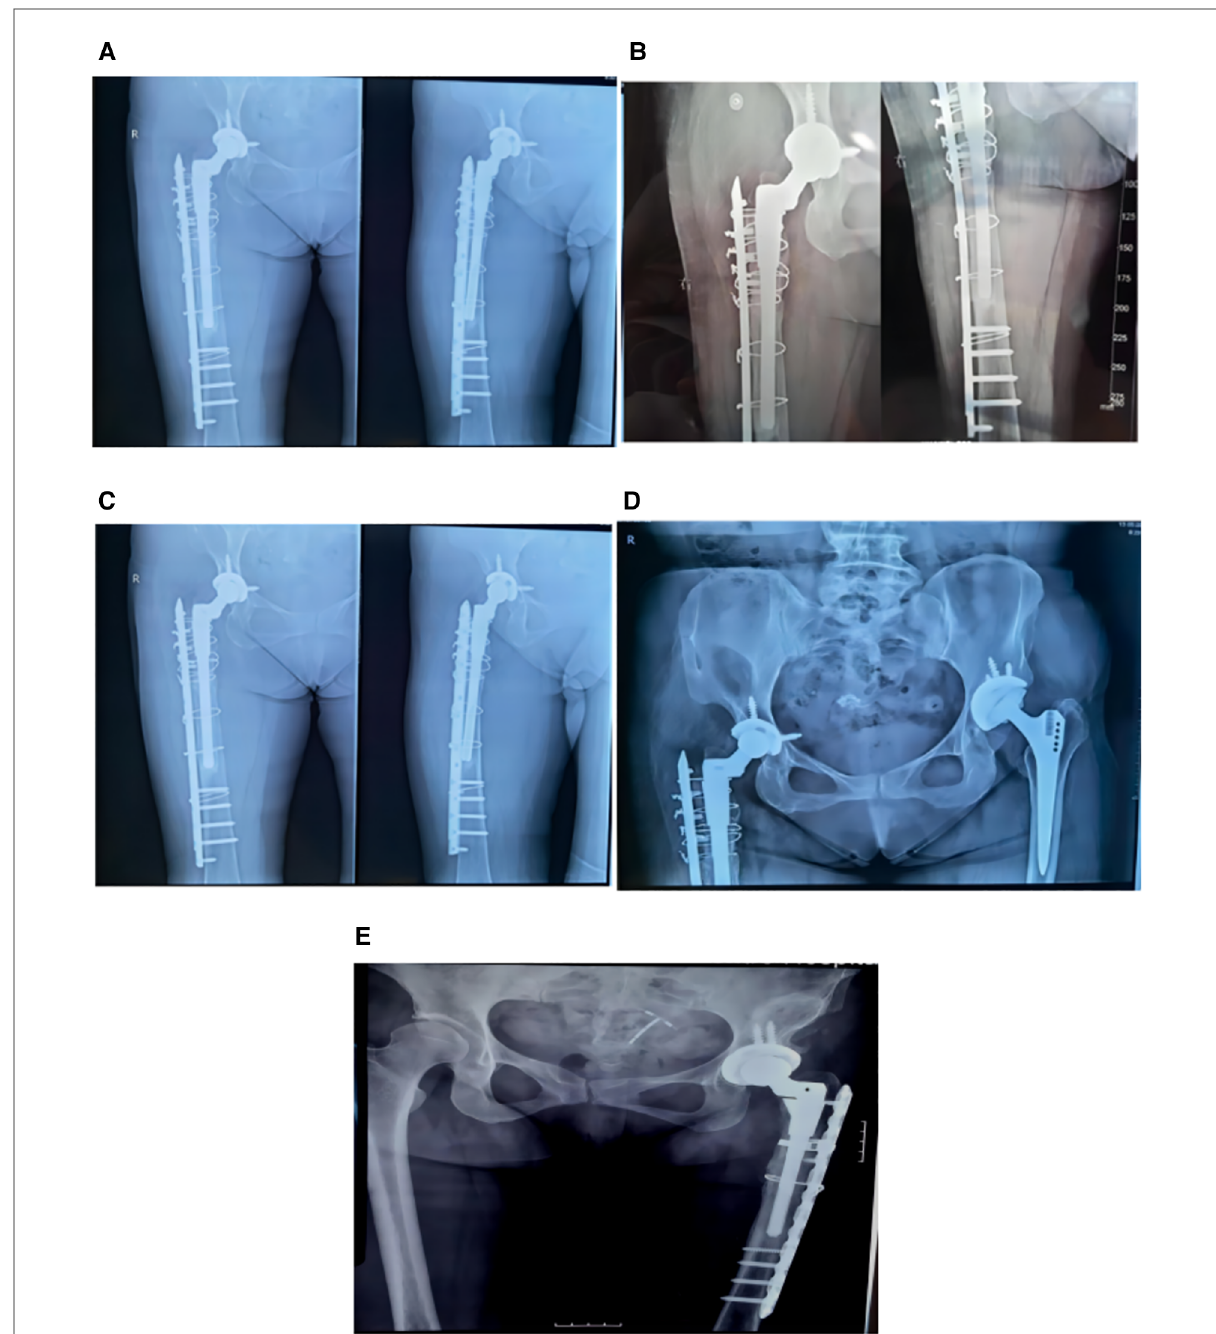
FIGURE 4 ( A ): the review results of patient 1 1 month after surgery; ( B ): the review results of patient 1 3 months after surgery. ( C ): anteroposterior femur of patient 1, 1 year after surgery; ( D ): anteroposterior pelvis of patient 1, 1 year after surgery. ( E ): The review results of patient 3 1 year after